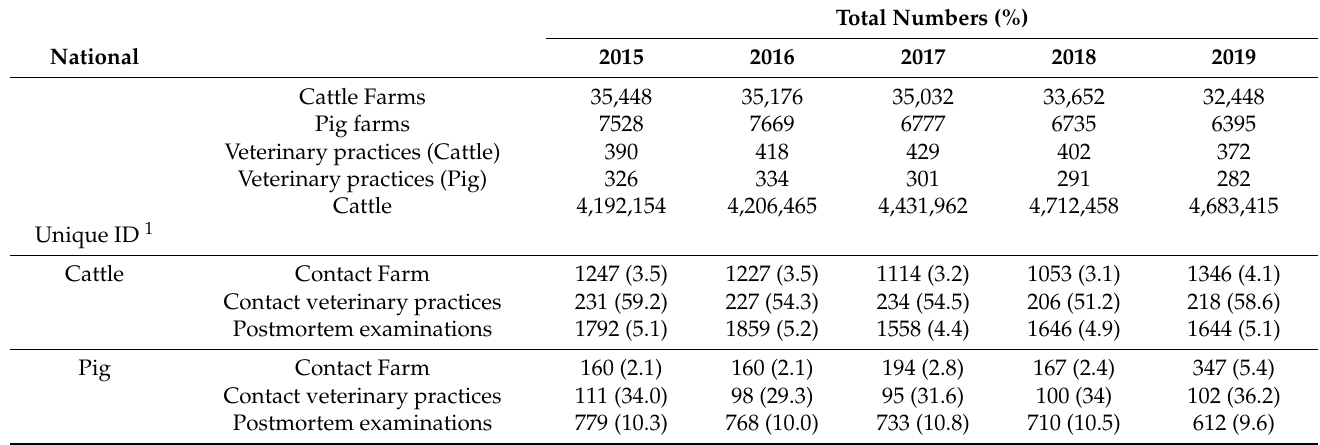
Table 6. Descriptive statistics of the total number of farms and veterinary practices in the Netherlands and the total number of farms and veterinary practices that had at least one moment of contact or submitted at least one animal for postmortem examination, respectively, in the period between 2015 and